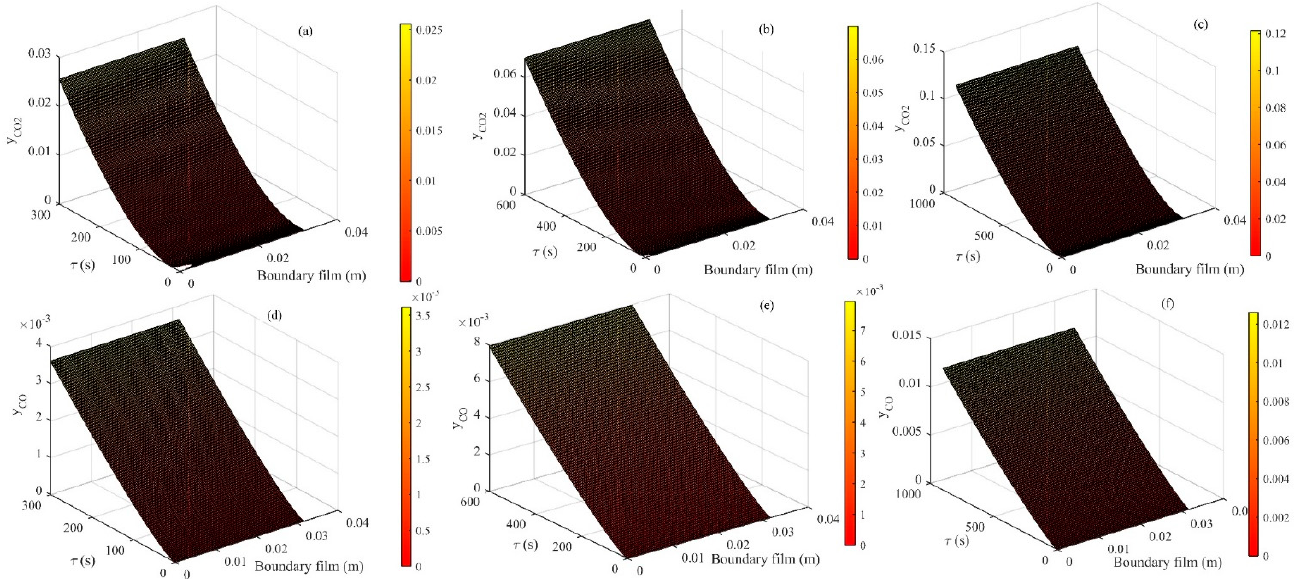
Figure 13. The distribution of mass fraction across the gas film (dynamic condition) at different torrefaction time ( a ) 5 min,